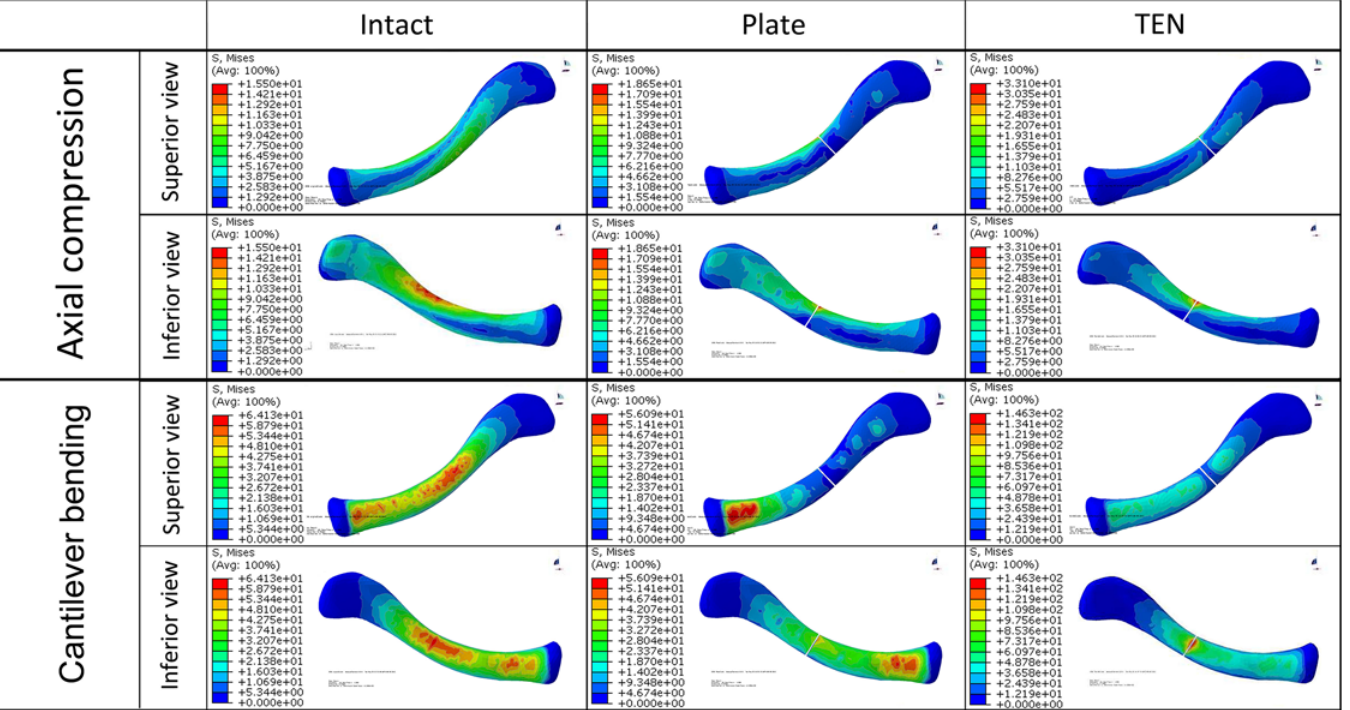
Fig 5. von Mises stress distribution in the bone of the three finite element models under both loading conditions.